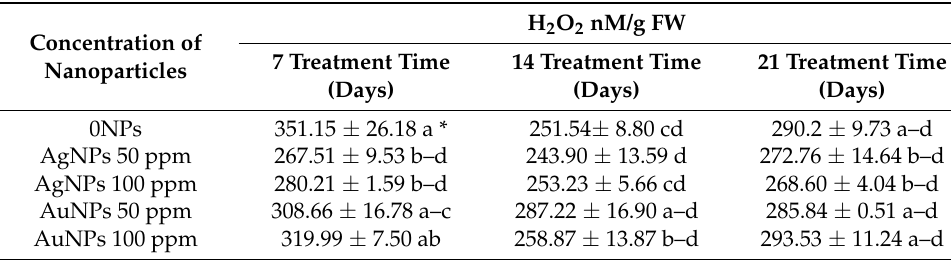
Table 6. Comparison of the influence of nanoparticles’ type and concentration on the H 2 O 2 content in rapeseed